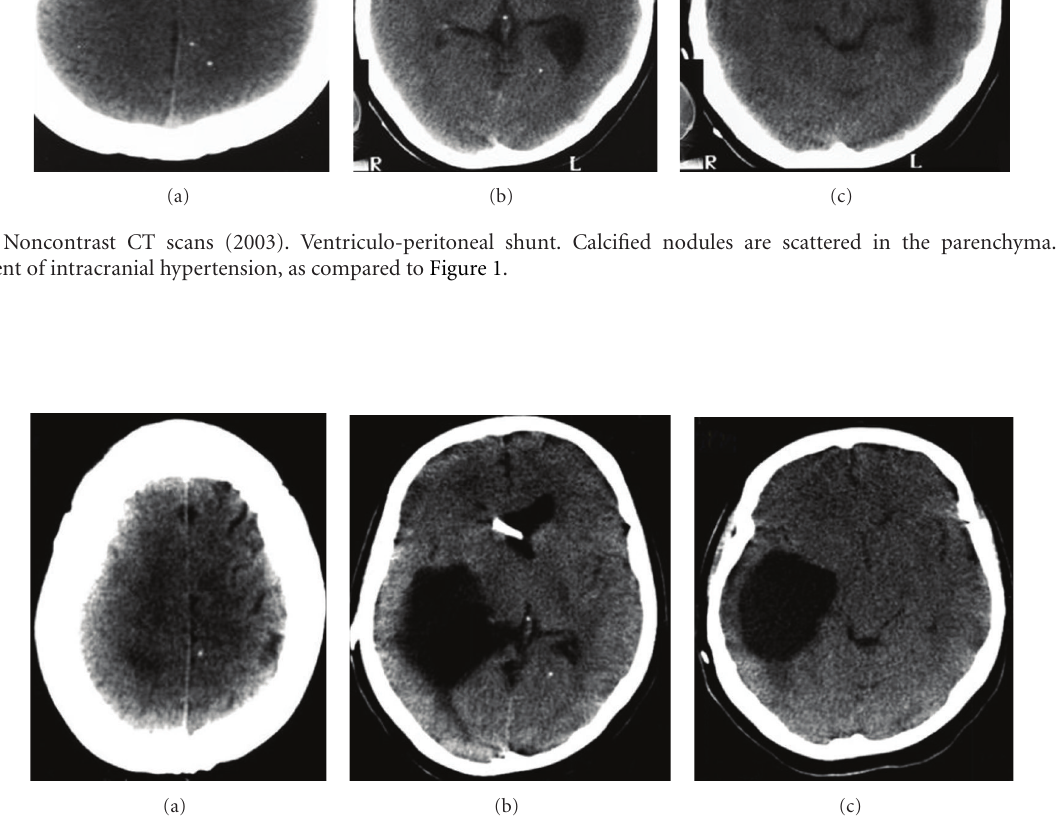
Figure 3: Noncontrast CT scans (2006). Ventriculo-peritoneal shunt with hypertensive obstructive